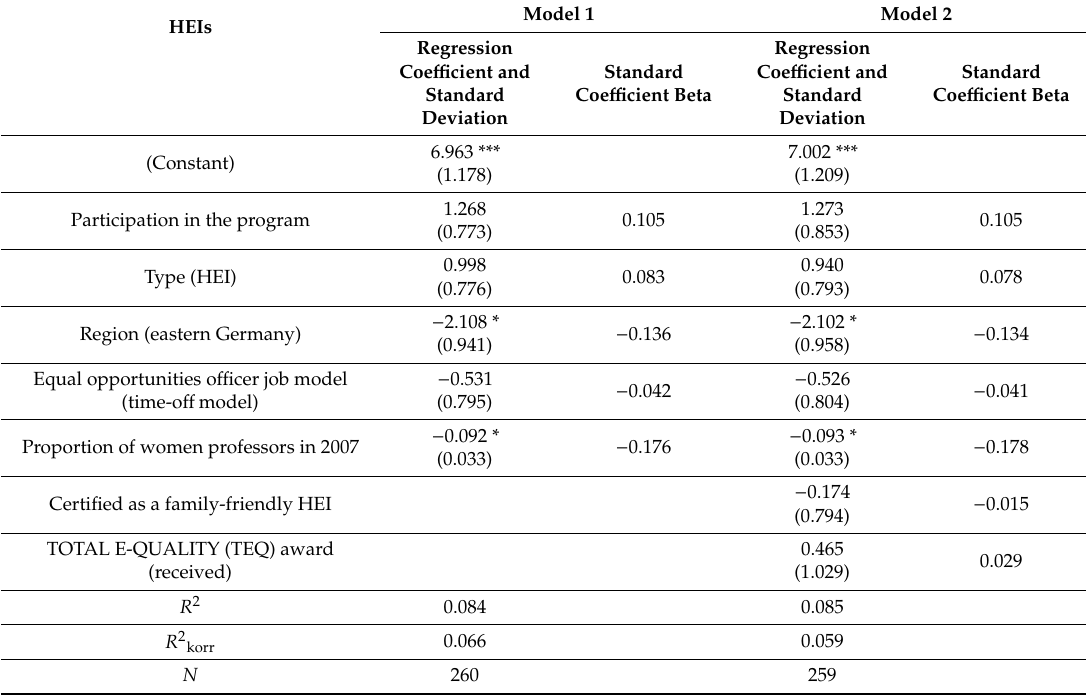
Table 5. Linear Regression: Changes in the Proportion of Women Professors between 2007 and 2015.